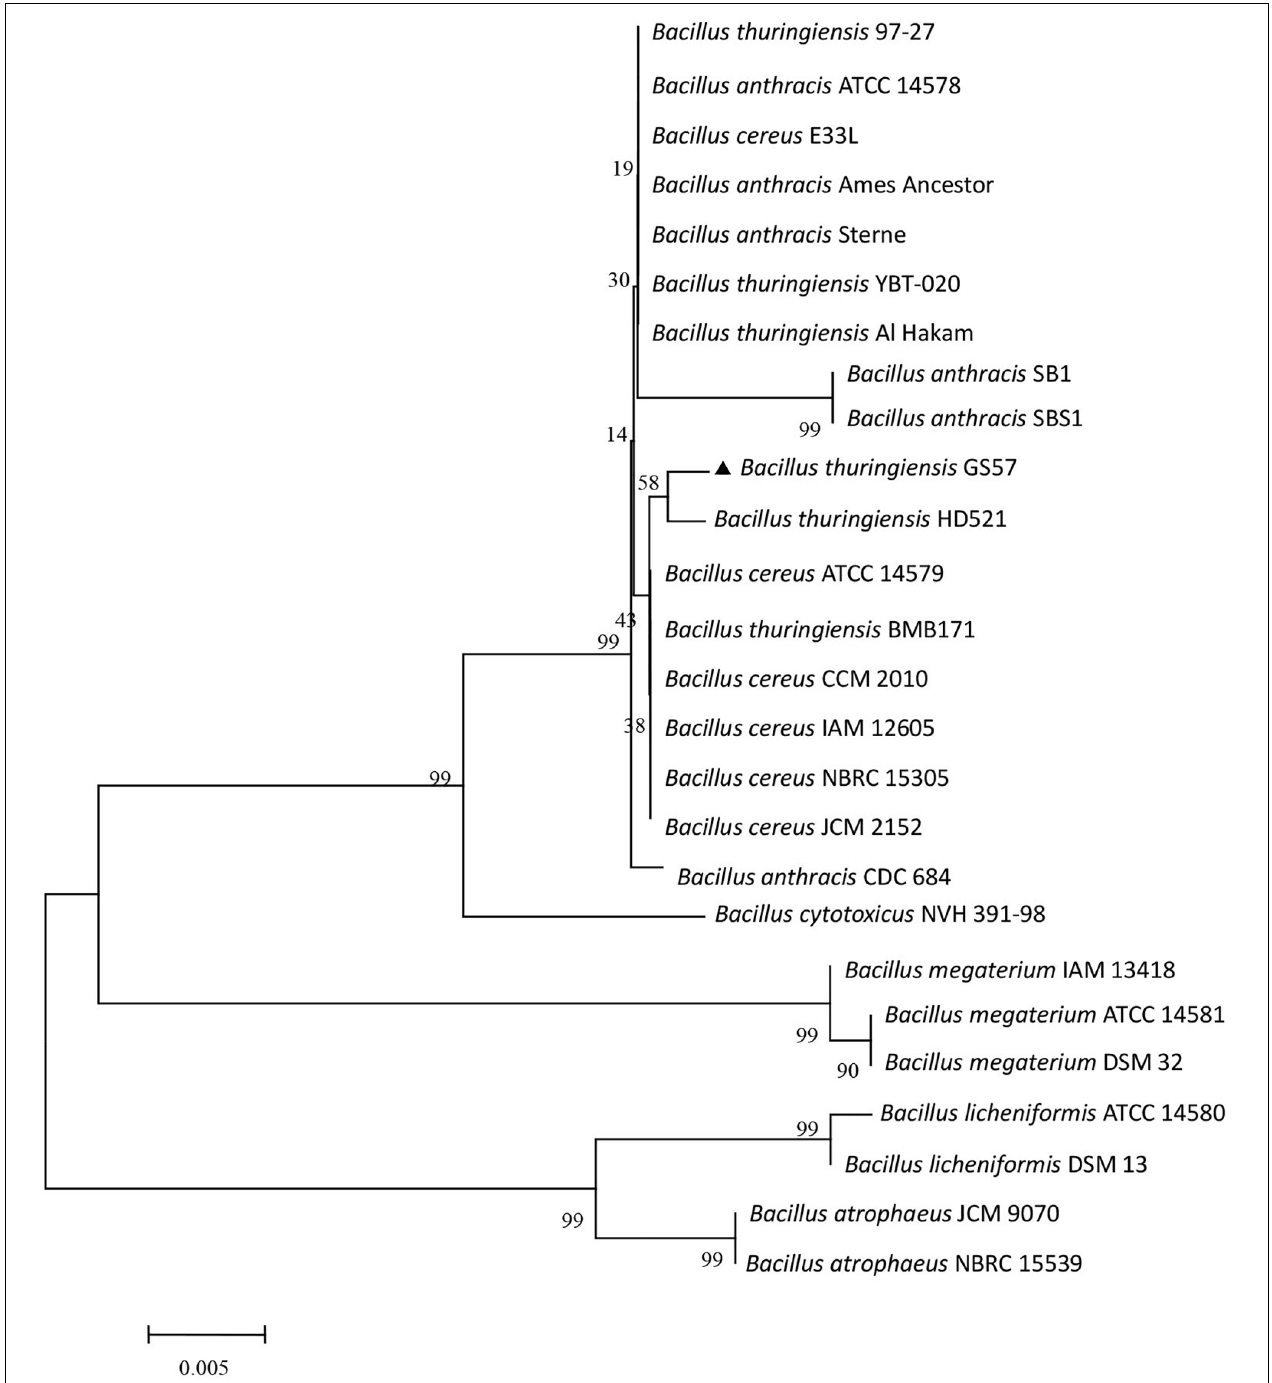
FIGURE 2 | Phylogenetic tree based on 16S rDNA sequences Bt GS57 and Bacillus cereus sensu lato species group. The strains and their 16S rDNA corresponding to the GenBank accession numbers given below: Bacillus thuringiensis BMB171 (CP001903.1); B. thuringiensis HD521 (CP010106); B. thuringiensis 97-27 (AE017355.1); B. thuringiensis YBT-020 (CP002508.1); B. thuringiensis Al Hakam (CP000485.1); B. cereus ATCC 14579 (AE016877.1); B. cereus E33L (CP000001.1); B. cereus CCM 2010 (NR_115714.1); B. cereus IAM 12605 (NR_115526.1); B. cereus NBRC 15305 (NR_112630.1); B. cereus JCM 2152 (NR_113266.1); Bacillus anthracis SB1 (NR_118379.1); B. anthracis ATCC 14578 (NR_041248.1); B. anthracis SBS1 (NR_118536.1); B. anthracis CDC 684 (CP001215.1); B. anthracis Sterne (AE017225.1); B. anthracis Ames Ancestor (AE017334.2); Bacillus megaterium ATCC 14581 (NR_117473.1); B. megaterium IAM 13418 (NR_043401.1); B. megaterium DSM 32 (NR_118962.1); Bacillus licheniformis ATCC 14580 (NR_074923.1); B. licheniformis DSM 13 (NR_118996.1); Bacillus atrophaeus JCM 9070 (NR_024689.1); B. atrophaeus NBRC 15539 (NR_112723.1); Bacillus cytotoxicus NVH 391-98 (CP000764.1).